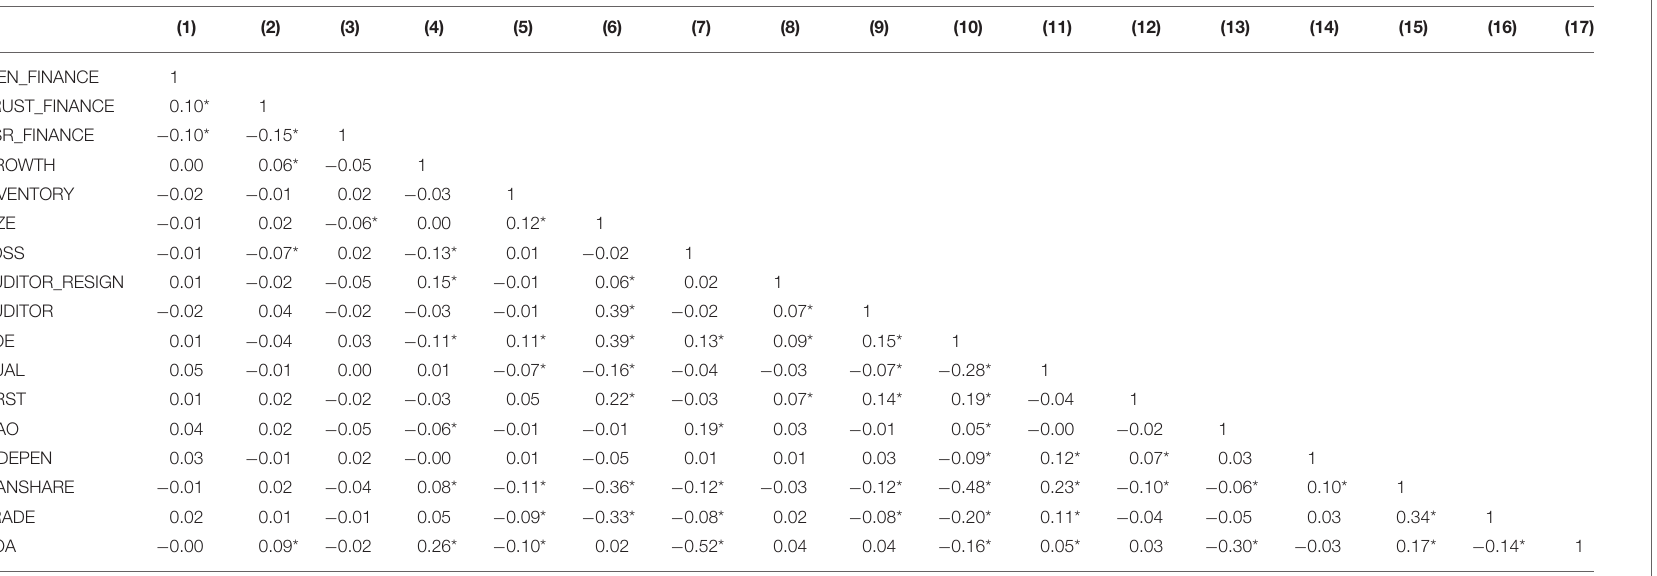
TABLE 6 | Correlation analysis: financial